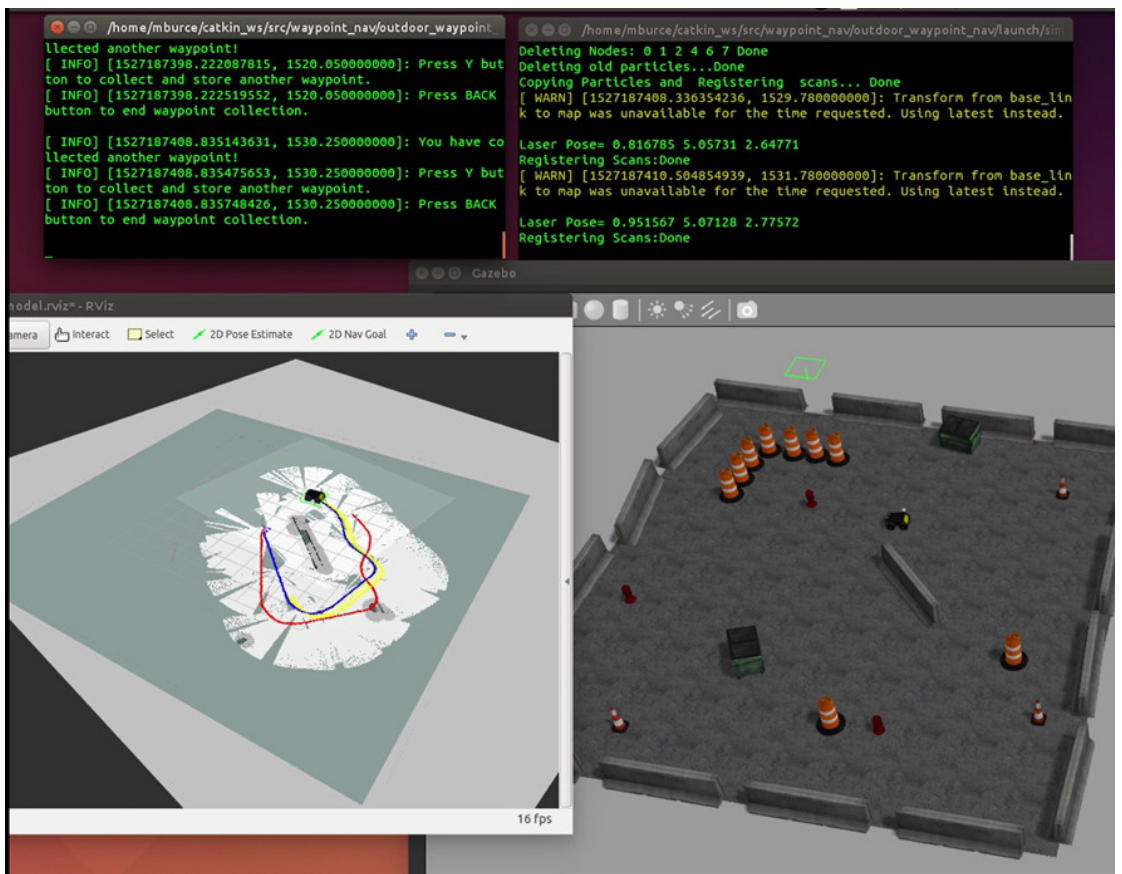
Figure 9. Screenshot of simulated navigation showing unmanned ground vehicle’s (UGV) path and movement.